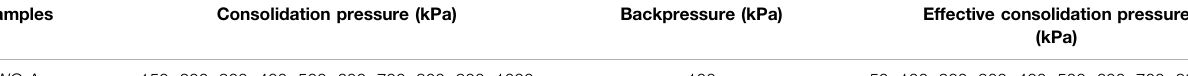
TABLE 4 | Experimental schemes of resonant column tests.